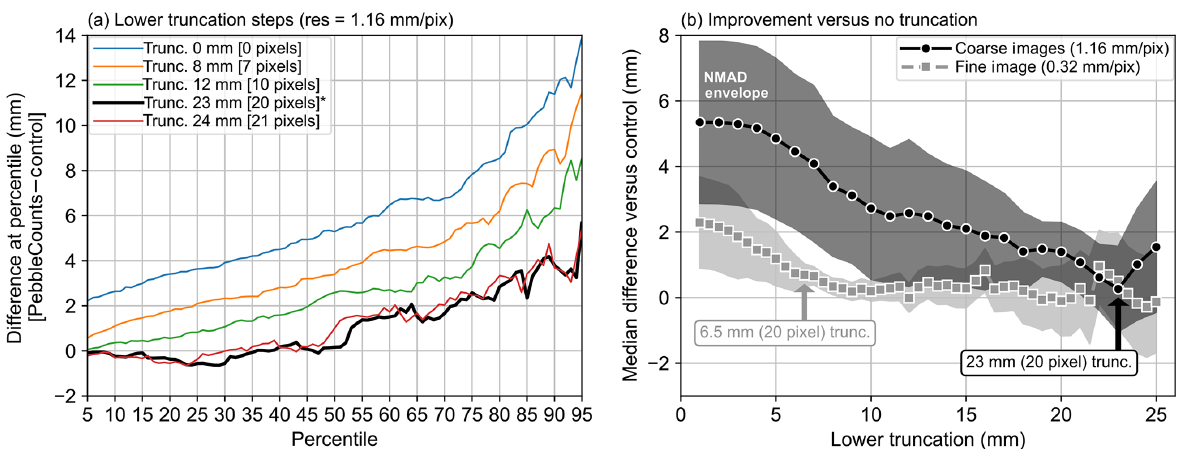
Figure 10. (a) Error in each percentile (5th–95th) as lower truncation value is increased in 1mm steps for the 1.16mmpixel − 1 imagery. Only a few steps are plotted for clarity. (b) The median difference in percentiles compared with the control versus the lower truncation value, with the normalized median absolute difference (NMAD) shown as the error envelope (Höhle and Höhle, 2009). From this analysis, we select a lower truncation of 20 pixels. The analysis in panel (a) was repeated for the finer image (with 0.5mm truncation steps) to get the gray squares line in panel (b) and is not shown here.